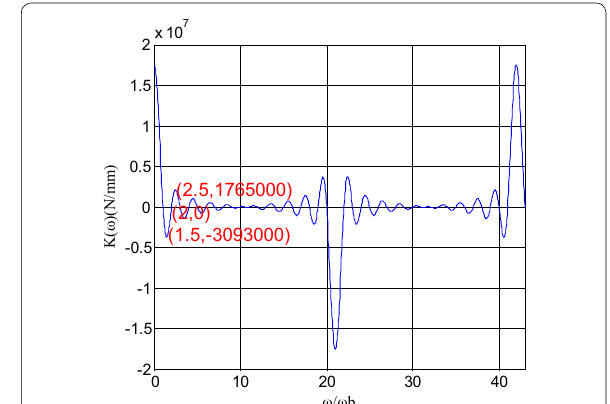
Figure 5 Characteristics of the transfer function